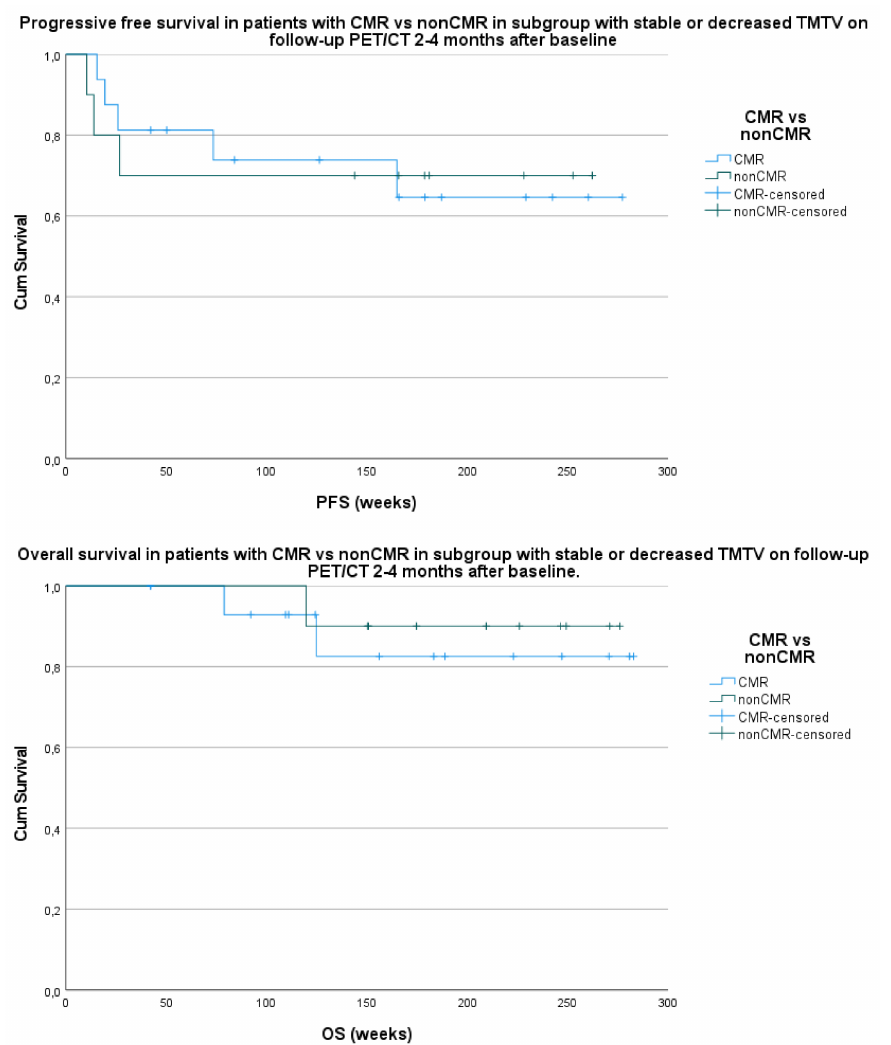
Figure 3. Comparison of survival parameters PFS ( above ) and OS ( below ) with patients with a complete metabolic remission (CMR) versus patients with residual disease or non-complete metabolic remission (nonCMR) and a stable or decreased total metabolic tumor volume (TMTV) on follow-up PET/CT 2–4 months after baseline